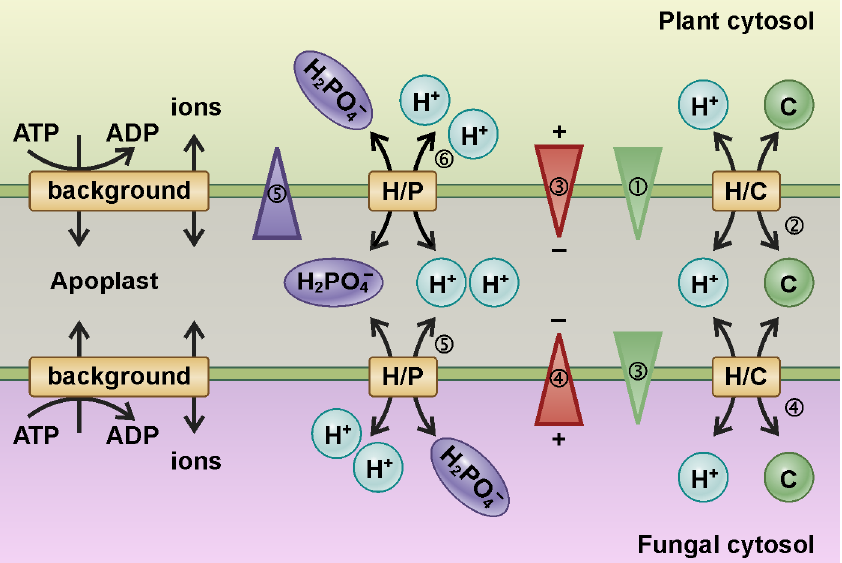
Figure 3. A minimal transporter system to explain the electrochemical coupling of nutrient transport at plant—fungi interfaces. For details, see the text. An animated version of this Figure can be found in the Supplementary Materials (Animation S2).